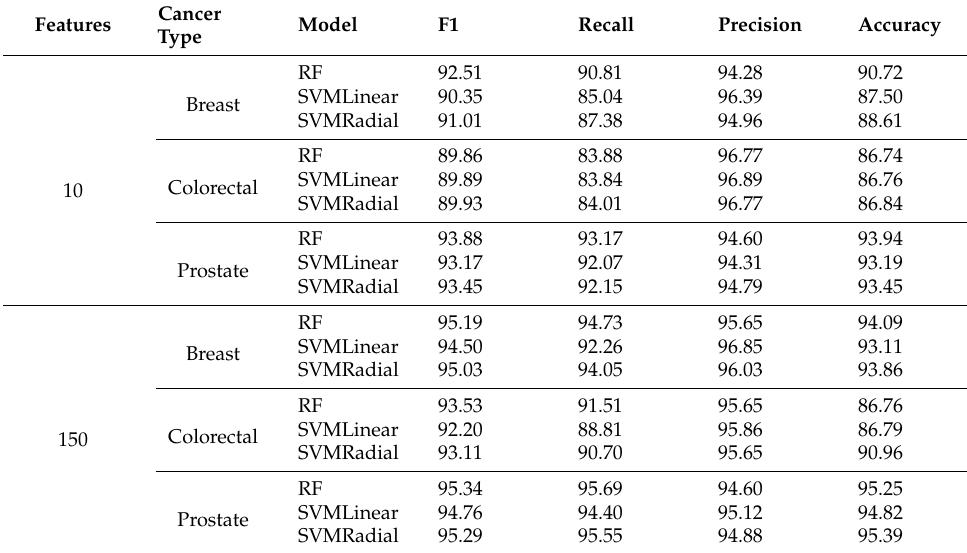
Table 3. Performance measures of the classifiers at 10 and 150 feature sizes for the three studied